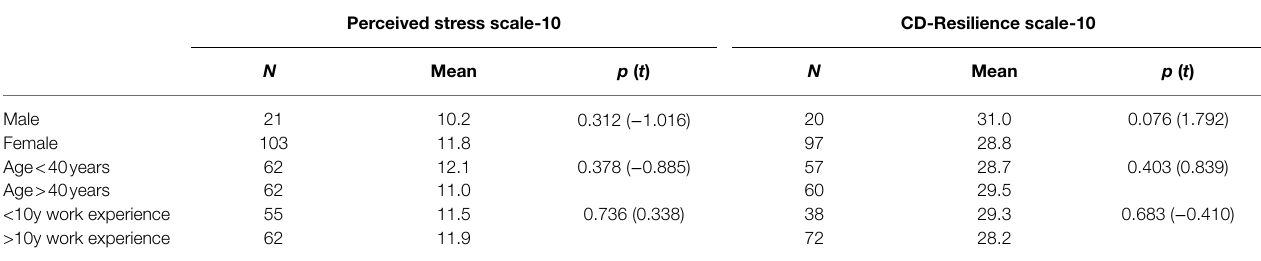
TABLE 2 | Mean scores on PSS-10 and CD-RISC-10 compared with socio-demographics.